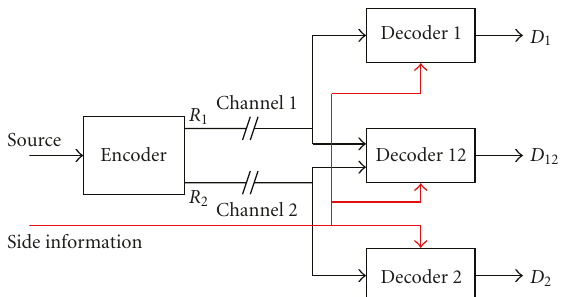
Figure 1: Two-description source coding with common decoder- only SI.